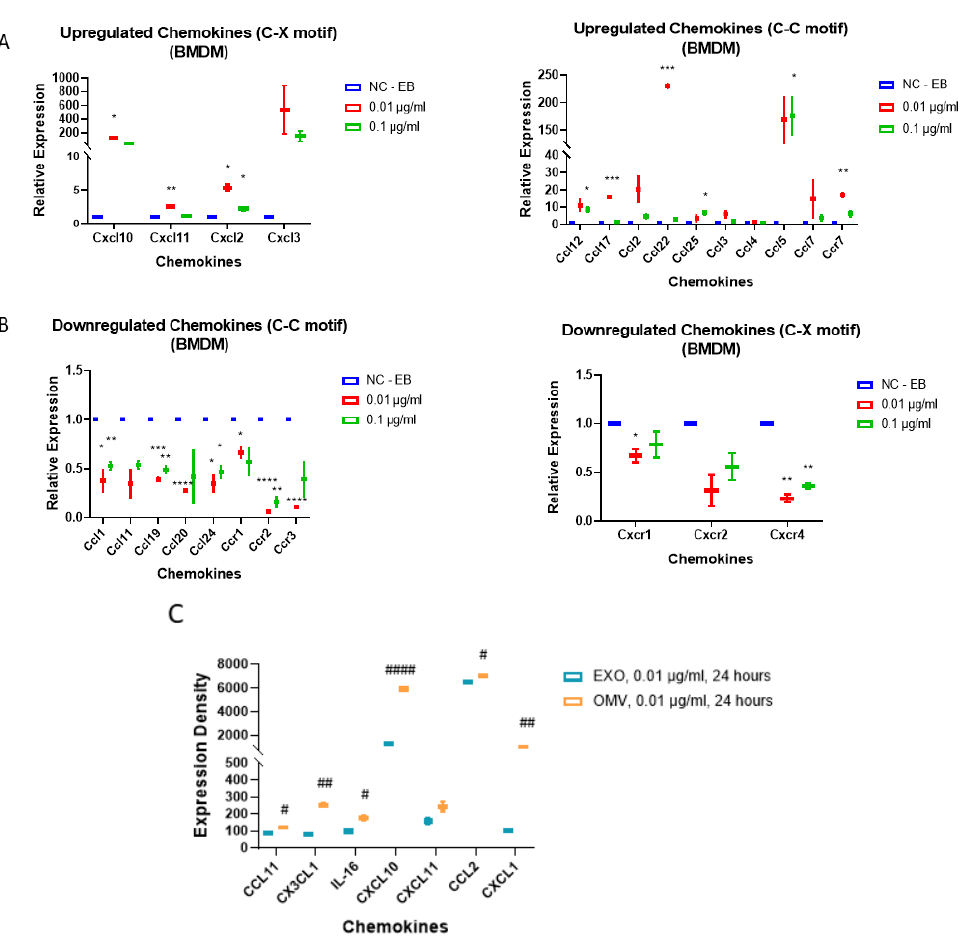
Figure 4. OMVs treatment in macrophages induces pro-inflammatory cytokines and chemokines. ( A , B ) BMDM were treated with OMVs at the indicated doses, after 24 h, mouse inflammation and autoimmune arrays were used to screen for candidates involved in OMV-stimulated inflammatory